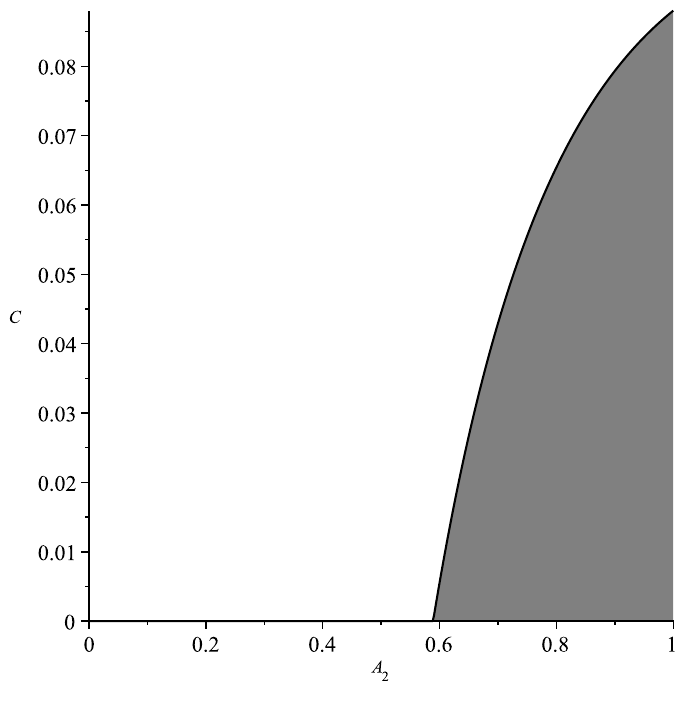
Figure 4. Possible values of A 2 and C